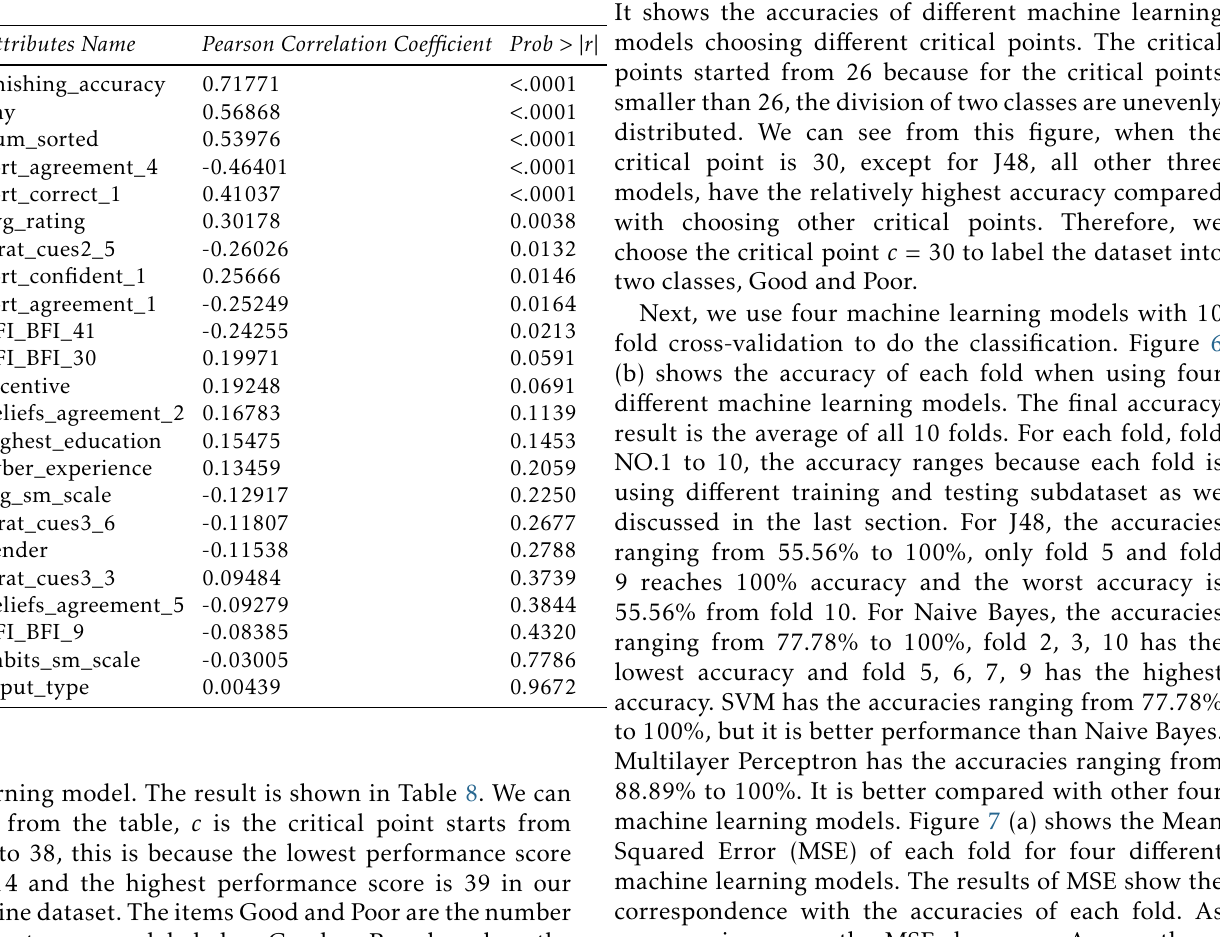
Figure 5. Time comparison for normal email and phishing Email Table 7. Pearson Correlation